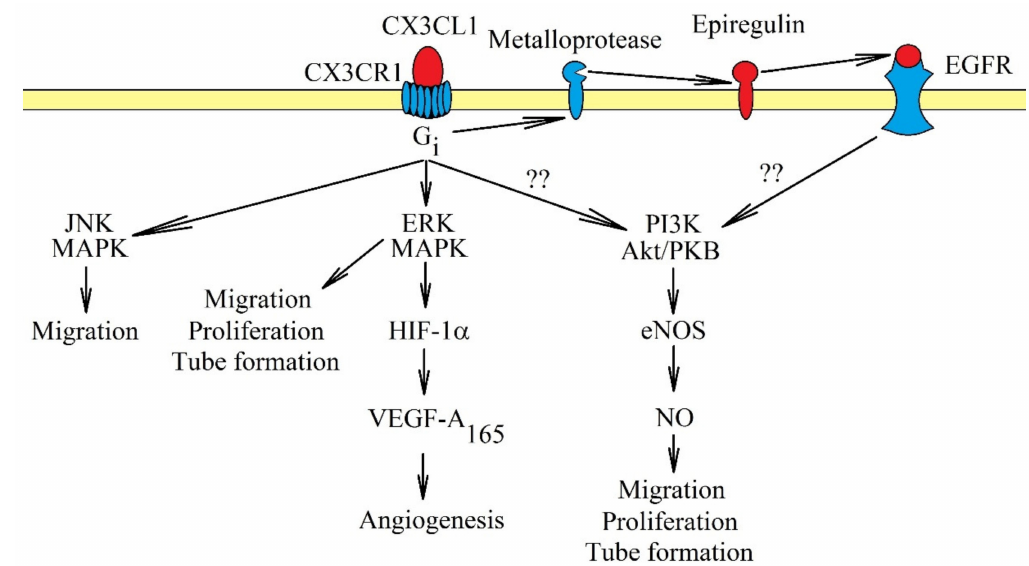
Figure 4. Intracellular signaling in endothelial cells in the induction of angiogenesis by CX3CL1. Activation of CX3CR1 causes signal transduction in endothelial cells, which causes